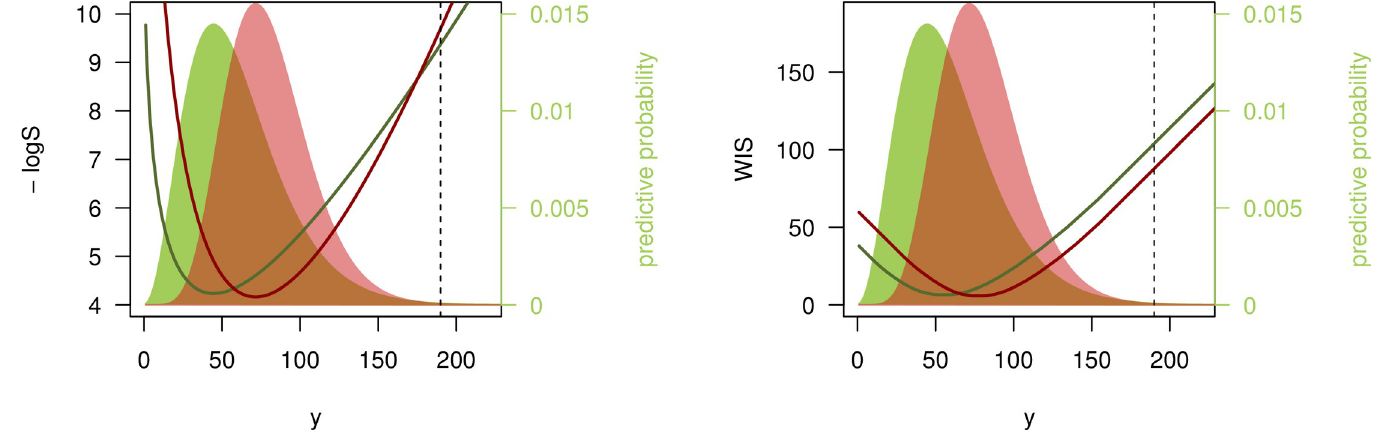
Fig 3. Disagreement between logarithmic score and WIS. Negative logarithmic score and weighted interval score (with α 1 = 0.02, α 2 = 0.05, α 3 = 0.1, ... , α 11 = 0.9 ) as a function of the observed value y . The predictive distributions F (green) and G (red) are negative binomials with expectations μ The black dashed line shows y = 190 as discussed in the